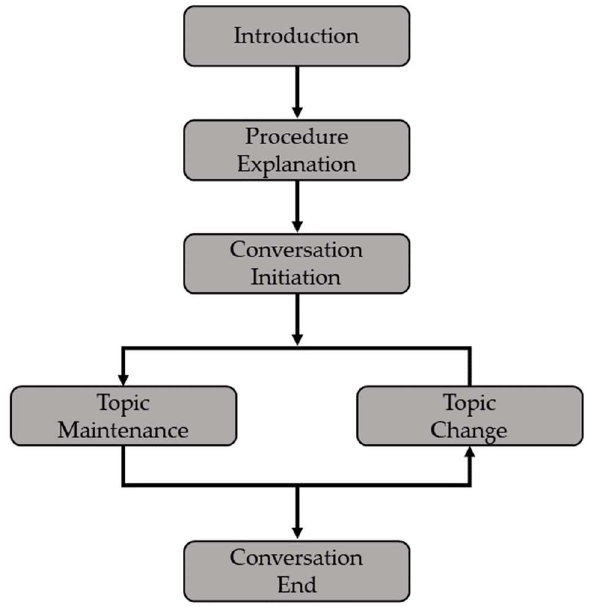
Figure 1. Conversation collection protocol process.